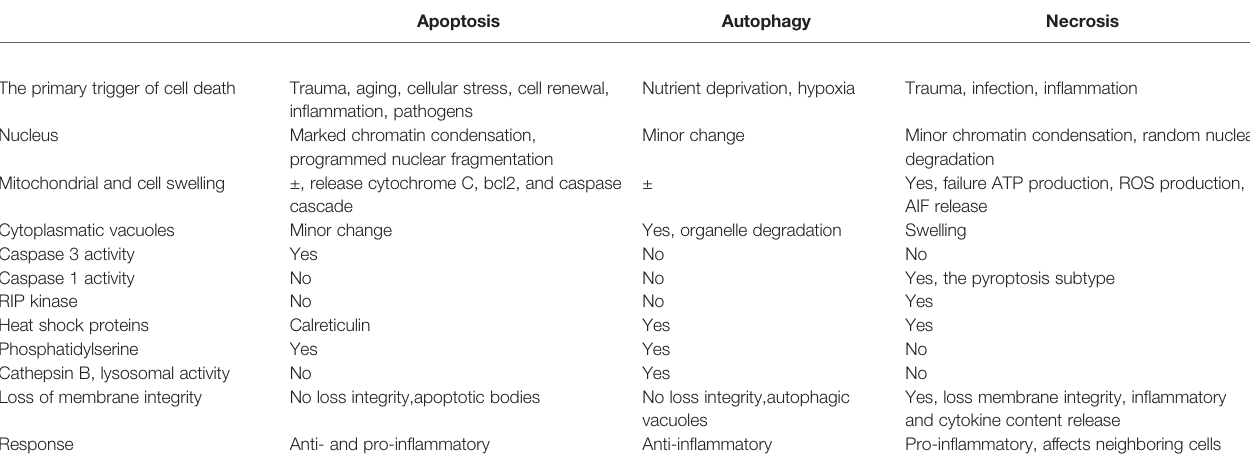
TABLE 1 | Major differences among apoptosis, autophagy, and